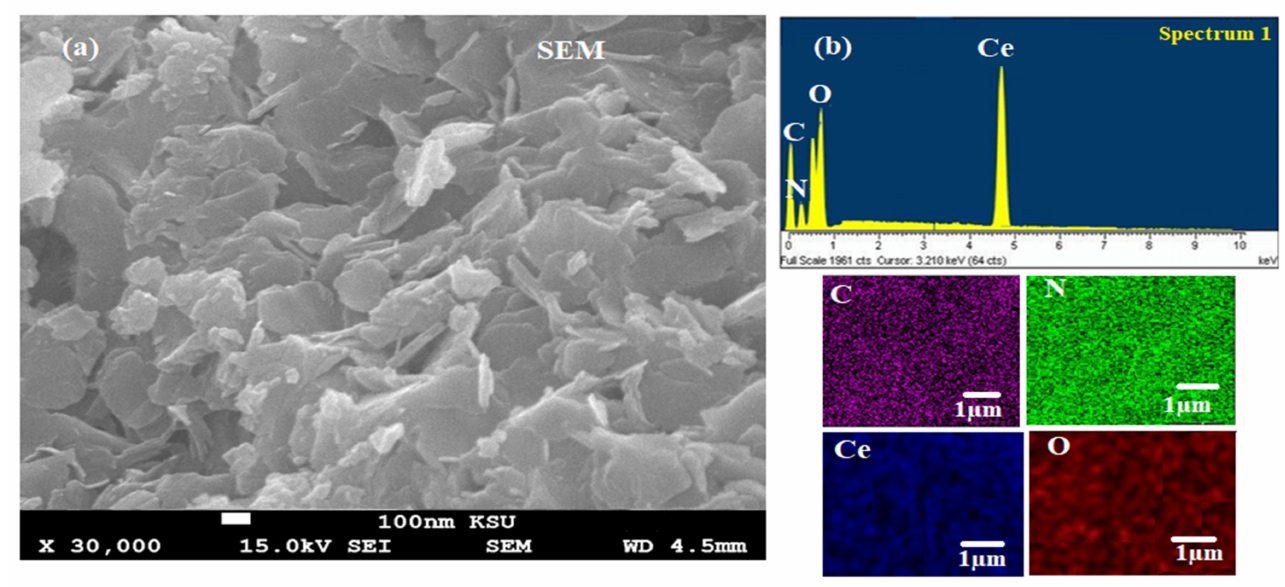
Figure 5. ( a ) SEM of biogenic CeO 2 NPs using maize silk extract and ( b ) EDX of the synthesized CeO2NPs with their elemental mapping.